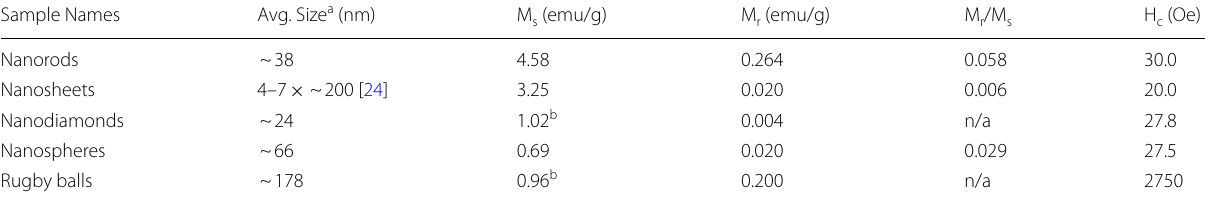
a Determined from SEM images b